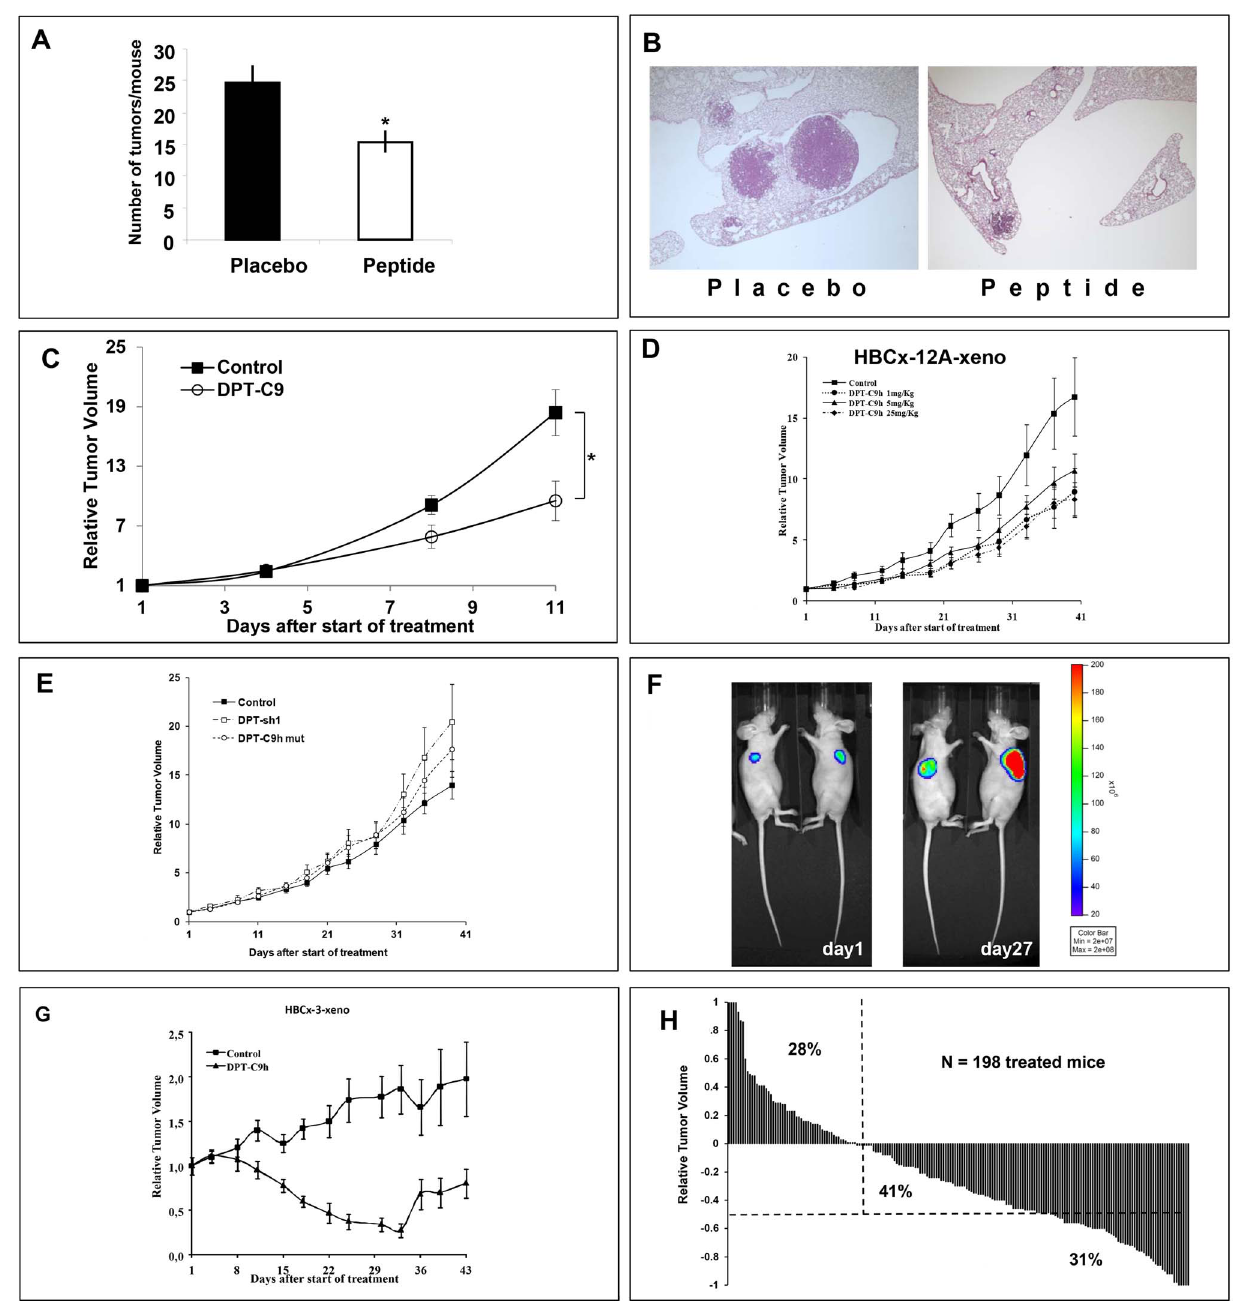
Figure 6. Invivo therapeutic efficacy of DPT-C9 and DPT-C9h. A ) The peptide DPT-C9 was administrated IP at 5 mg/kg once daily, 5 days a week for 4 weeks in the K-Ras LA1 adenocarcinoma mouse model, showing a significant decrease in lung tumour burden compared to control formulating vehicle-treated mice (p=0.01). B ) Histological analysis of lung tumours of control treated only with the formulating vehicle and DPT-C9 - treated mice. C ) DPT-C9 was administrated IP as for the K-Ras LA1 model in mice bearing xenografted mouse PyMT breast tumours, with a significant TGI of 46% after 11 days of treatment compared to control mice treated with the formulating vehicle. D ) DPT-C9h was administered IP at 1, 5, or 25 mg/kg once daily for 5 weeks in mice bearing HBCx-12A tumours (triple negative model). Ten mice were included per group and the control group was treated with the formulating vehicle. E ) DPT-sh1 and DPT-C9hM was administered IP at 1.5 mg/kg and 5 mg/Kg respectively, once daily for 5 weeks in mice bearing HBCx-12A tumours generated from the HBCx-12A cell line. Ten mice were included per group. F ) DPT-C9h was administered IP at 5 mg/kg in mice bearing HBCx-12A cell line previously infected with a Ds-Red-Luc + lentivirus. Bioluminescence imaging was shown in two mice (out ten), one receiving control vehicle (right mouse) and the other treated by DPT-C9h (left mouse). G ) DPT-C9h was administrated IP at 5 mg/kg in mice bearing HBCx-3 (luminal model) once daily for five weeks. Ten mice were included per group. H ) Relative variation of all treated tumours. In all in vivo experiments, mice of the control groups received 0.2 ml of the drug-formulating vehicle with the same schedule as the treated animals. Growth curves were obtained by plotting mean RTV against time. When RTV of all treated mice were considered from positive ration (resistant tumours) to negative ratio (sensitive tumours), we observed that 72% of all 198-treated mice have negative ratio, showing that peptide treatment has a high in vivo anti-tumour effect in BC xenografted models.